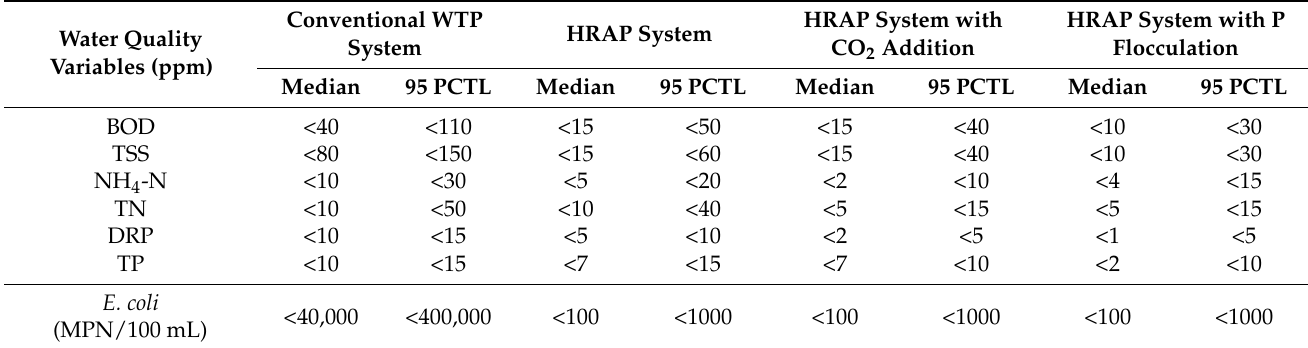
Table 4. Effluent quality of HRAP system compared with conventional wastewater treatment ponds in New Zealand (Integrated Tables 1 and 2 in Craggs et al.